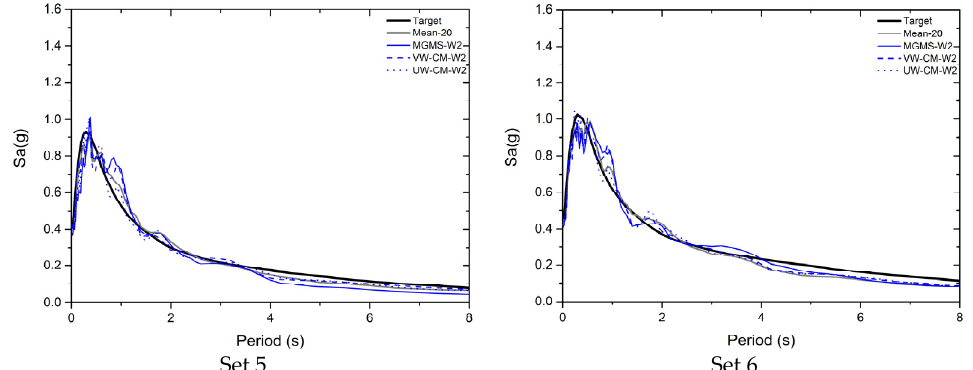
Table A4. Details of IGMs of motion sets 7 and 8.